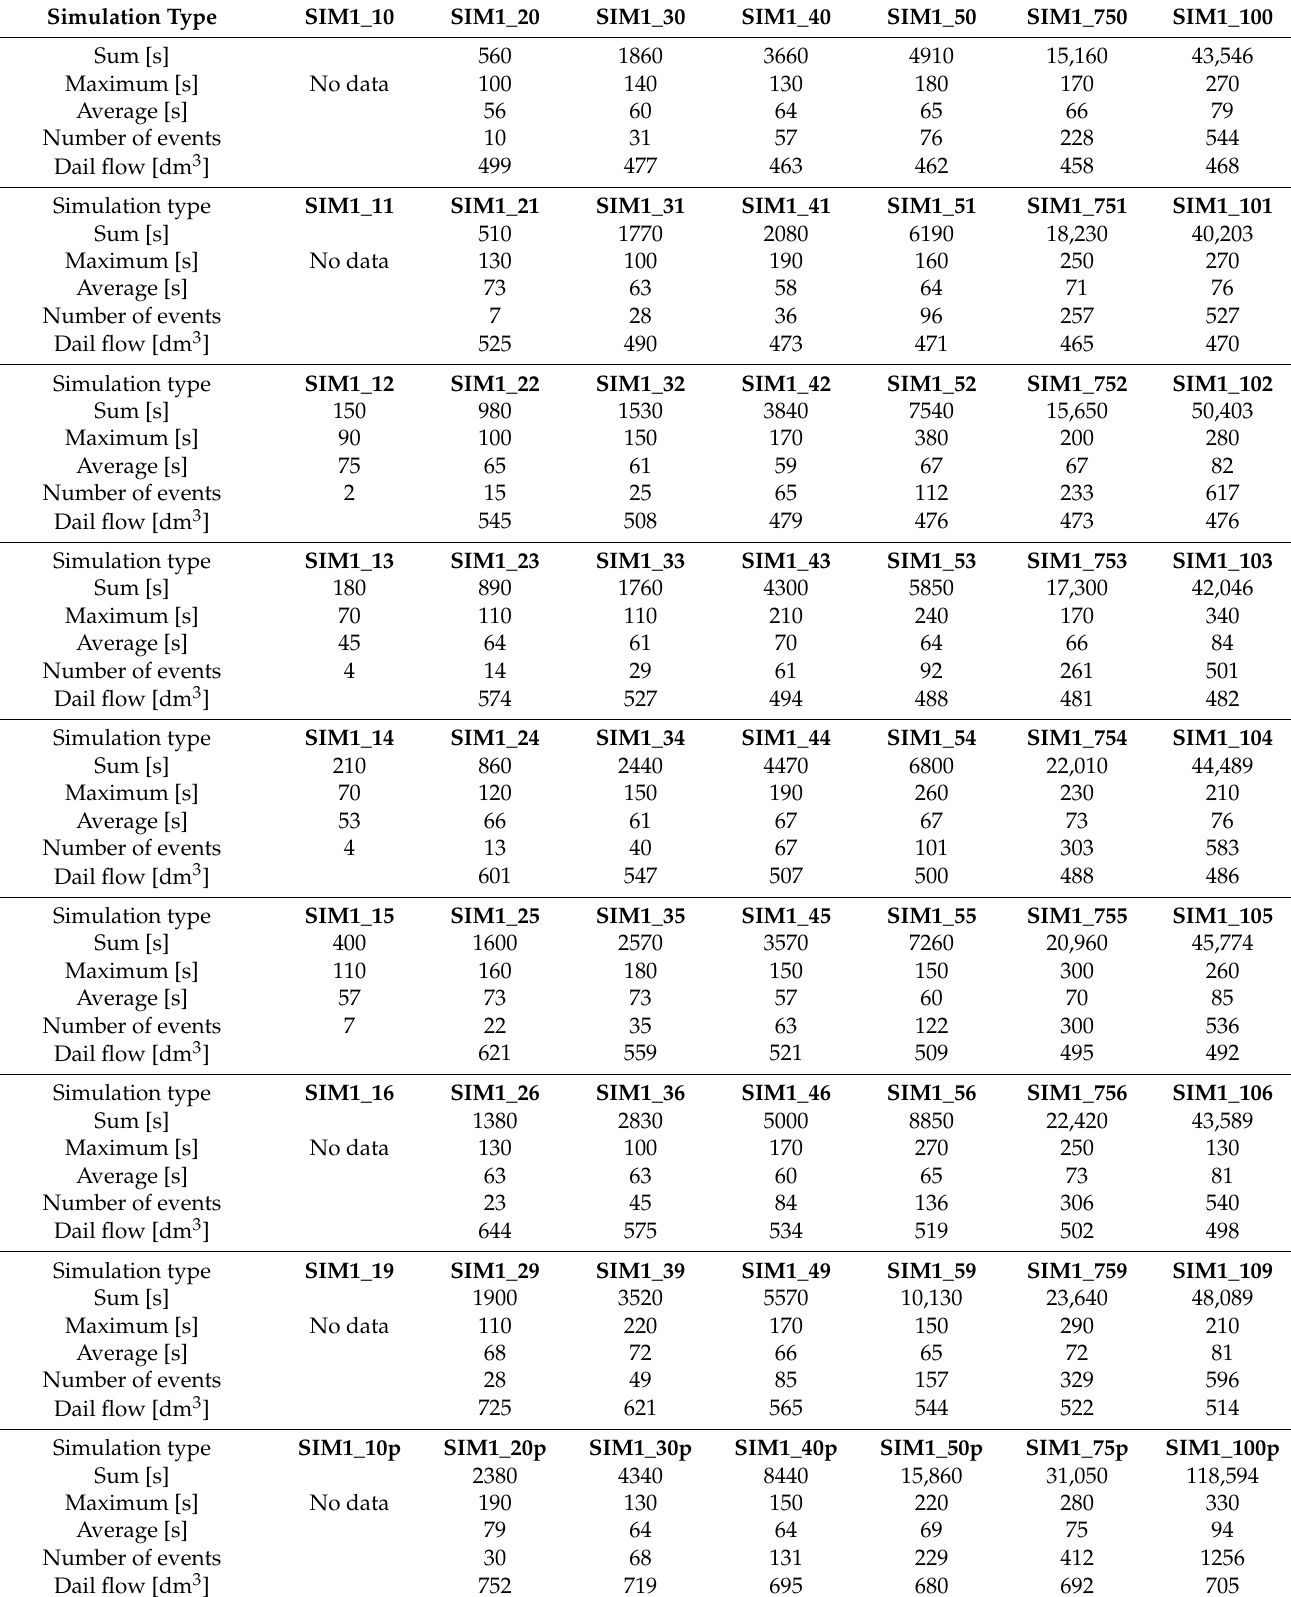
Table A1. Simultaneous operation parameter listings for a pumping station with V = 148 dm 3